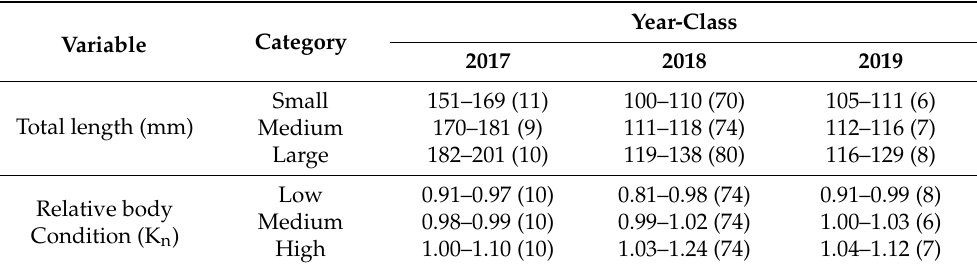
Table 1. Variables and associated category values (minimum–maximum) for the Kaplan–Meier analysis of time to out-migration for juvenile bull trout sampled from Graves Creek, Montana, in the summer of 2018 and 2019 (sample size in